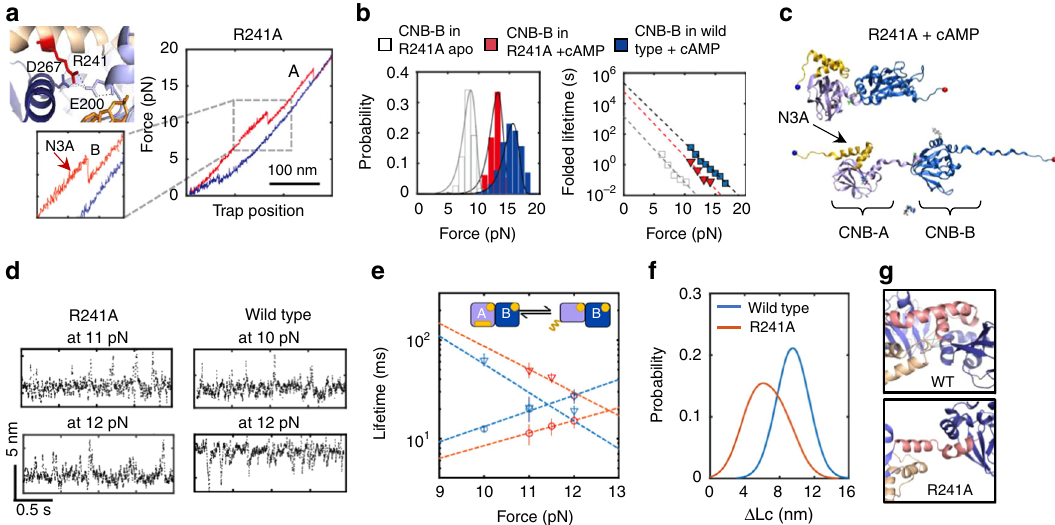
Fig. 6 Perturbation of allosteric networks in PKA by mutation R241A. a Residue R241 interacts with both CNB domains through E200 and D267 (PDB 1RGS). Force-extension curve for R241A bound to cAMP (type-III construct S110C/S376C). Zoomed-in is the unfolding rip corresponding to the N3A motif. b Unfolding probability distributions and force-dependent folded-state lifetimes for the CNB-B domain in R241A apo (gray) or bound to cAMP (red). For reference, the wild-type data were included (blue). Solid lines are the unfolding force distribution reconstructed from force-dependent lifetimes. c SMD simulation snapshot of the cAMP-bound R241A protein. d Representative force-clamp trajectories of the N3A motif in R241A and wild type. Source data are provided as a Source Data fi le. e Force-dependent lifetimes of the N3A motif in the folded (triangles) and unfolded (circles) states for R241A (red) and wild type (blue). Error bars are the SD of different single molecules. f Distribution of the change in contour length ( Δ L c ) of the N3A motif for wild type (blue) and R241A (red). g The mutation R241A (bottom) hinders interactions established with the CNB-B domain seen in wild type (top). Source data for d and g are provided as a Source Data fi differences (Fig. 6a, right, and Supplementary Fig. 6). Speci fi cally, the average unfolding force for the CNB-B domain in the mutant protein was ~2.5 pN lower compared with wild type, which